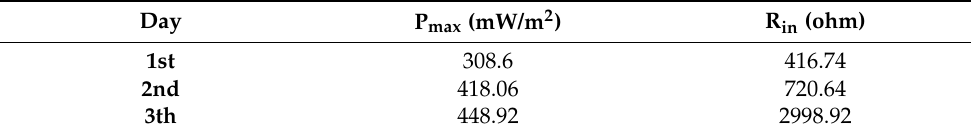
Table 2. Max power and internal resistance of the studied system per